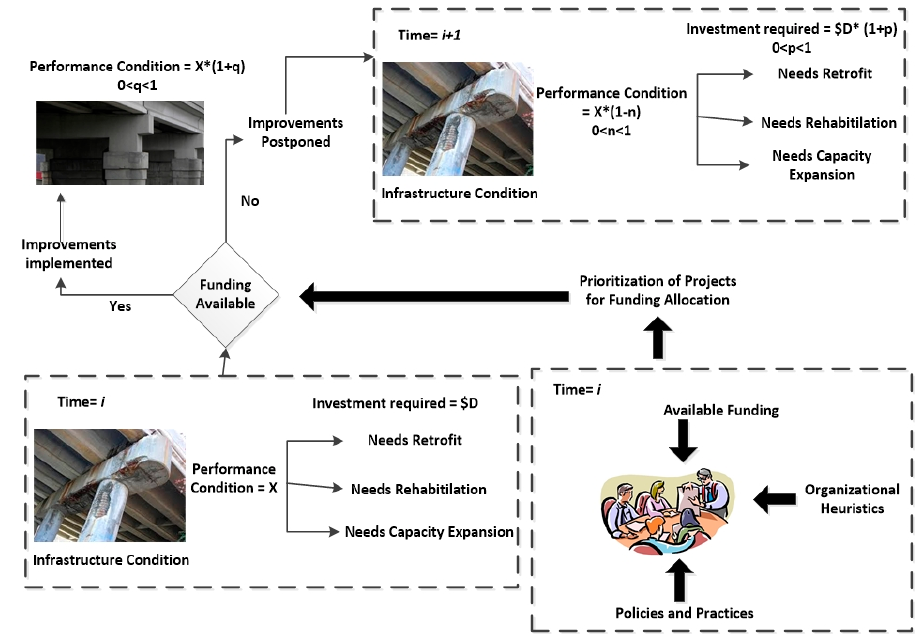
Figure 5. Impact of funding constraint on prioritization of maintenance/retrofit activities.